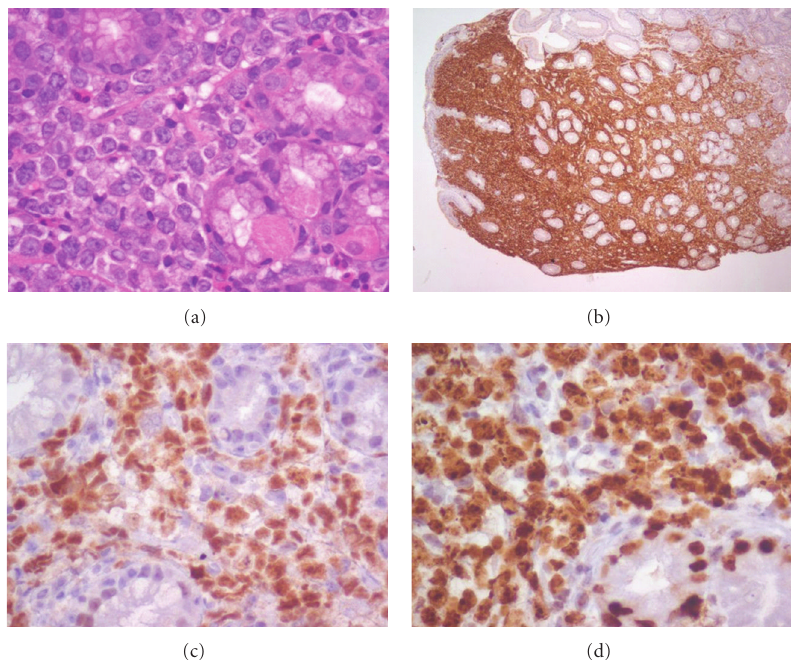
Figure 3: Stomach biopsy: (a) H&EX40 (Olympus BX40)—DLBCL, (b) antibody staining CD 20+, (c) antibody staining BCL6+, (d) antibody staining